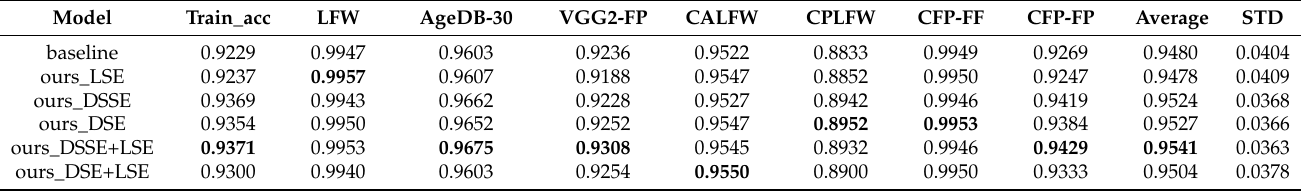
Table 4. The test results of the models with different SE modules. The data in the columns of LFW, AgeDB-30, VGG2-FP, CALFW, CPLFW, CFP-FF, and CFP-FP represent the accuracy of the model on different test sets. These test sets are described in detail in Section 4.1. Bold is to highlight the optimal value of each column, making it more obvious and impressive.